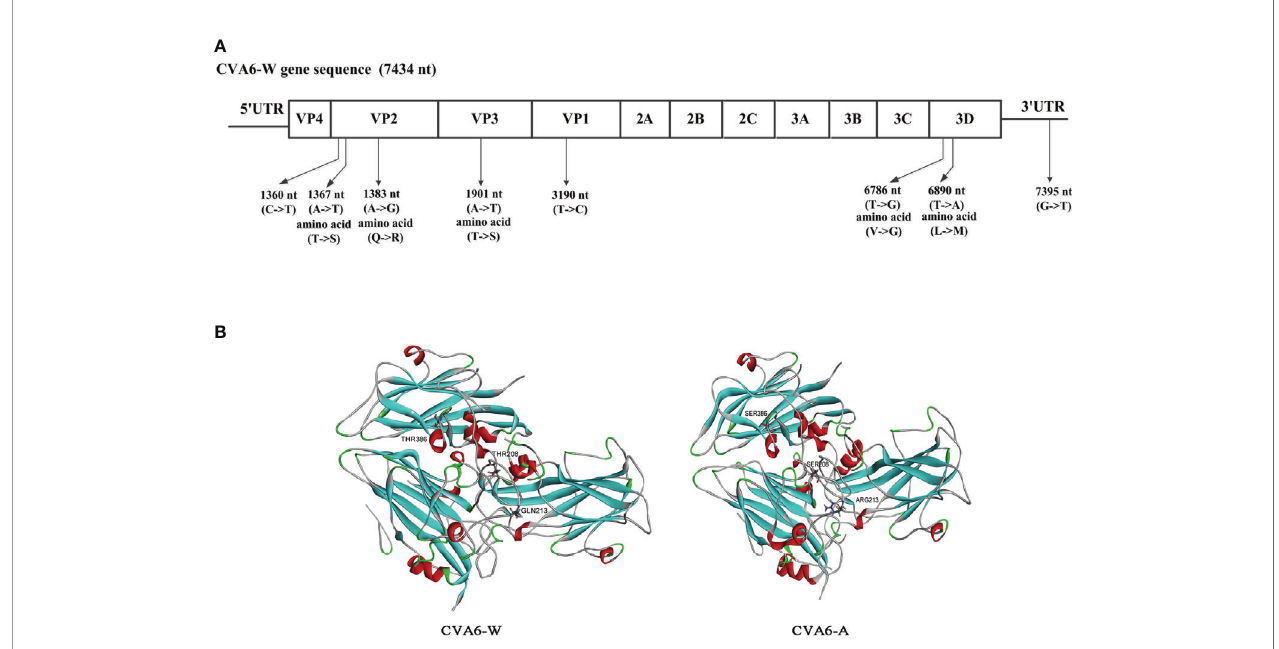
FIGURE 8 | Comparative genomic analysis of the coxsackievirus A6 (CVA6) adapted strain (CVA6-A) with the parental CVA6 Gdula strain (CVA6-W). (A) Differences in nucleic acid and amino acid sequences are shown along with CVA6-W genomic locations and coding sequences. No insertion or deletion was found in CVA6-A genome. (B) Structural model of heterotrimeric capsid protein (VP2, VP3, and VP1) of CVA6-W and CVA6-A showing the variant amino acids.